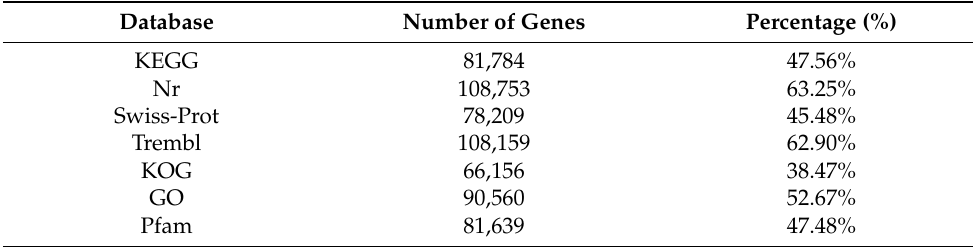
Table 4. Statistics related to